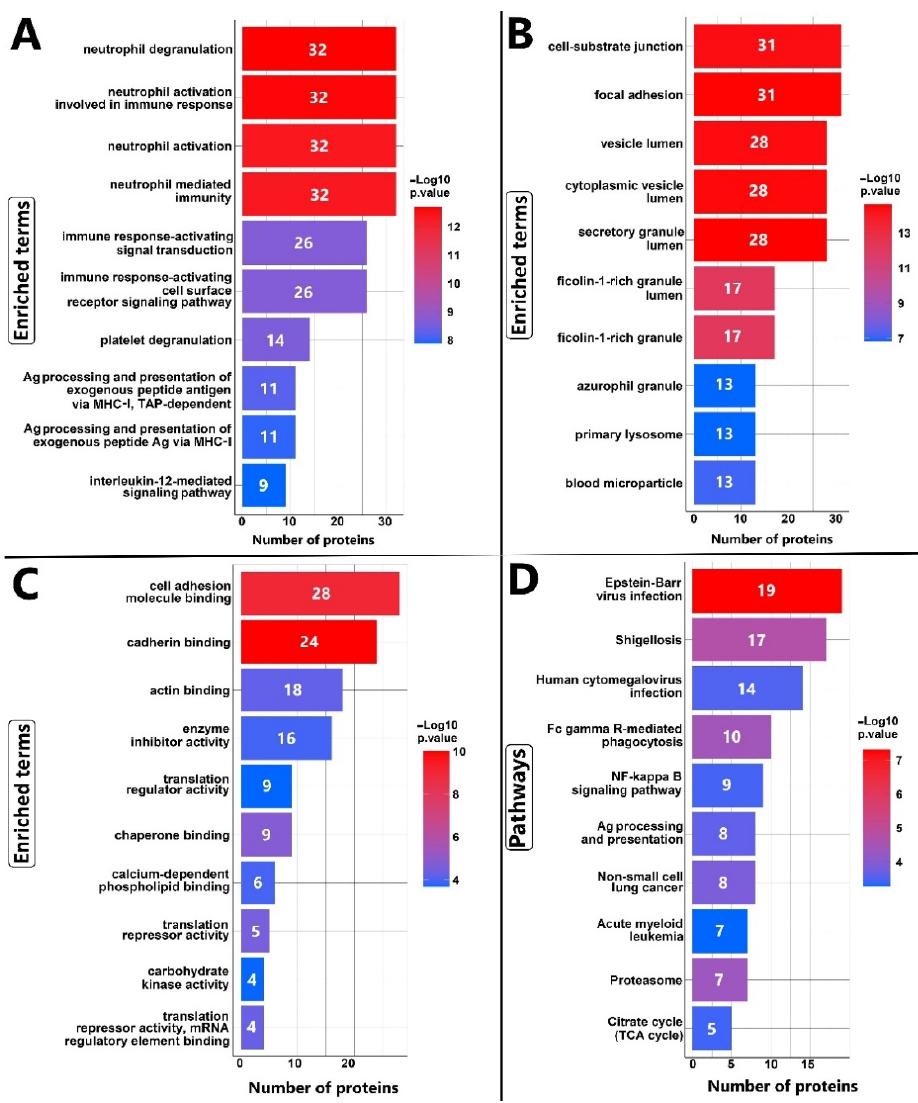
Figure 5. GO enrichment analysis and KEGG pathways for repeated proteins in at least four articles (n = 265). Bar plots represent the 10 most significant terms in ( A ) BP, ( B ) CC, and ( C ) MF, respectively. The bar plot ( D ) displays the top 10 most significant KEGG pathways. The number of proteins identified for each functional term is shown on the x -axis.